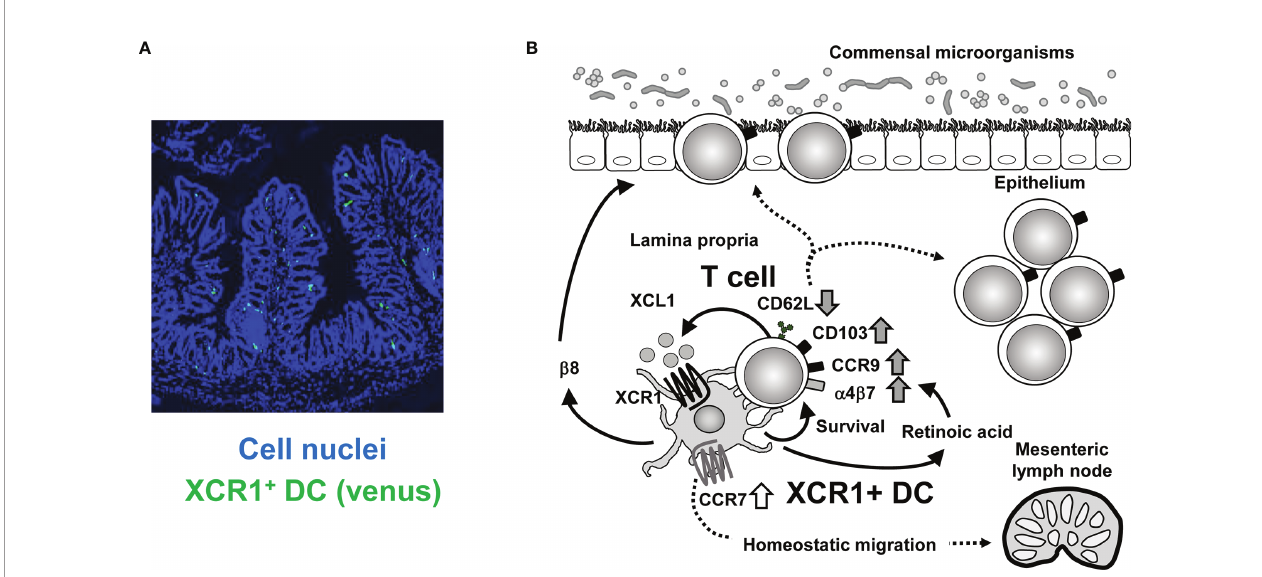
FIGURE 1 | Crosstalk between XCR1+ DC and intestinal T cells. (A) Immuno fl uorescence imaging of intestinal sections from XCR1-Venus ( Xcr1 +/venus ) mice. XCR1+ DC can be detected by Venus expression. Cell nuclei were stained with Diamidino-2-phenylindole. (B) Once activated, intestinal T cells produce XCL1, which attracts XCR1+ DC. XCR1+ DC support survival, upregulation of CD103, CCR9, a 4 b 7, and XCL1 expression, downregulation of CD62L expression and generation of CD4 +CD8 aa + IEL, thereby leading to maintenance of intraepithelial and LP T cell populations. T cell-derived XCL1 then keep CCR7 expression of XCR1+ DC to enable migration of XCR1+ DC from the LP to the mesenteric lymph nodes. High expression of XCR1 and b 8 integrin and high activity of aldehyde dehydrogenase, which can convert retinal to retinoic acid, contribute to XCR1+DC-dependent